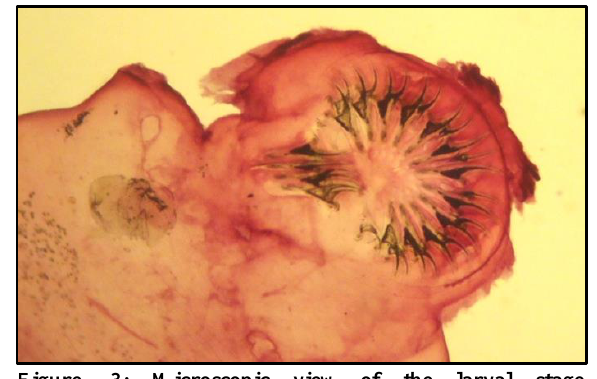
Figure, 3: Microscopic view of the larval stage (cysticercus) shows that the rostellum contained a scolex with two rows of taeniid